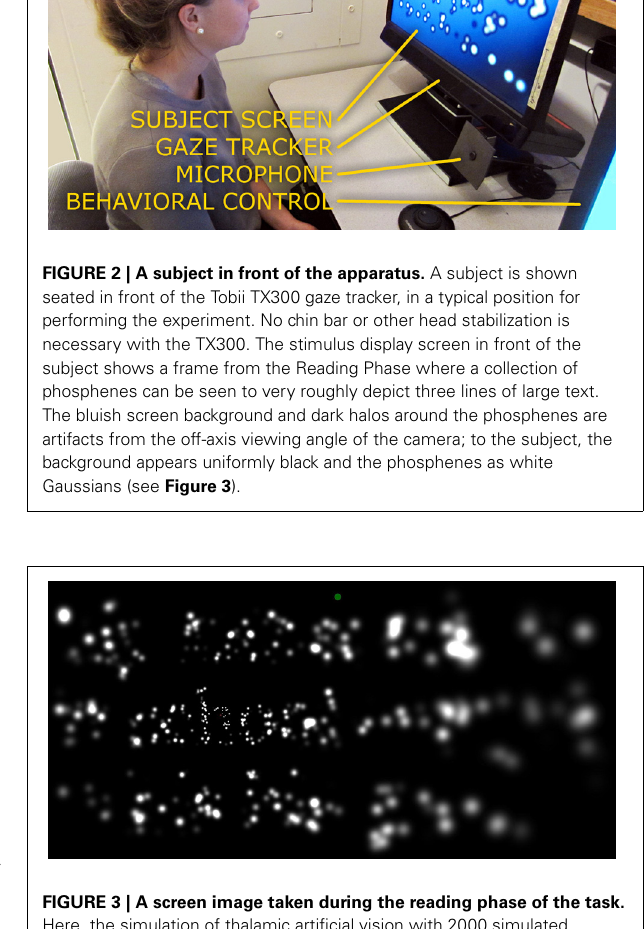
FIGURE 3 | A screen image taken during the reading phase of the task. Here, the simulation of thalamic artificial vision with 2000 simulated phosphenes (far fewer are engaged in this image, due to the limited extent of the display, and to the particular bright/dark pattern forming the text) is shown with the subject looking at text displayed at the largest font size. The image depicts the text “My father takes me/to school every day/in his big green car” with the point of regard alighted on the h in school . The details of image generation for phosphene vision are found in Figure 4 . As the point of regard moved around the screen, the pattern of phosphenes shifted accordingly, revealing more detail wherever the subject was looking. Because of the ability of the human visual system to integrate information across eye movements, the text appeared far more legible as a whole than this static image would imply. Every subject was able to read at the depicted condition (largest text with densest phosphene pattern) with relative ease and 100%